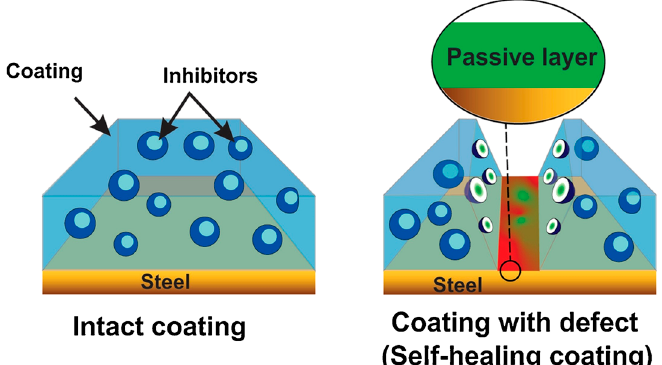
Figure 5. Self-healing mechanism of tannin-functionalized coating mixed with silane- hybrid ZnO nanoparticles, with passivation of the damaged steel surface by the formation of tannates. Reprinted with permission from Ref. [59]. Copyright 2019, A.F. Jaramillo, Progress in Organic Coatings, Elsevier.